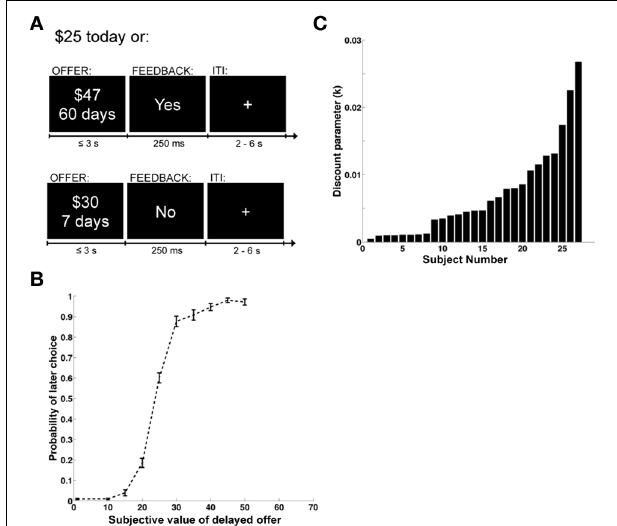
FIGURE 1 | Task design and behavioral data. (A) Example display screens and timing parameters. (B) Choice curve displaying the probability of choosing the larger, delayed reward. The y-axis shows the probability of selecting the future reward and the x-axis displays the stimulus value of the future reward. Error bars represent the standard error of the mean. (C) Bar graph showing the distribution of discounting parameters across subjects. The x-axis represents individual subjects and the y-axis is the magnitude of the discount parameter k from a hyperbolic discounting